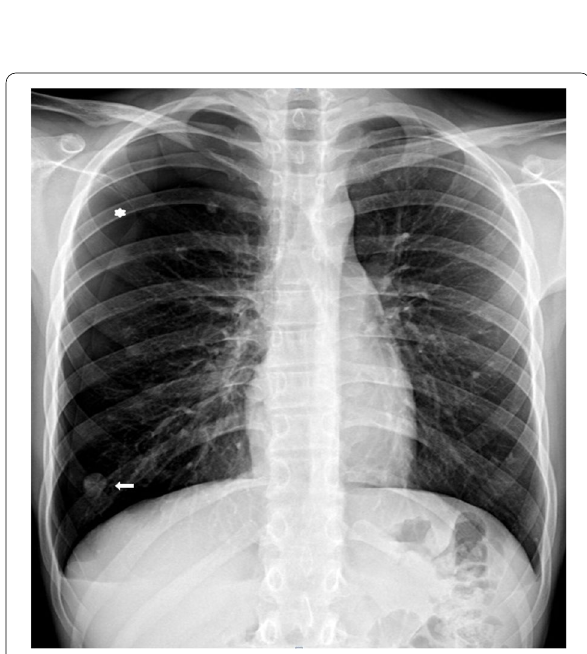
Fig. 8 Right pneumothorax with multiple pulmonary metastatic